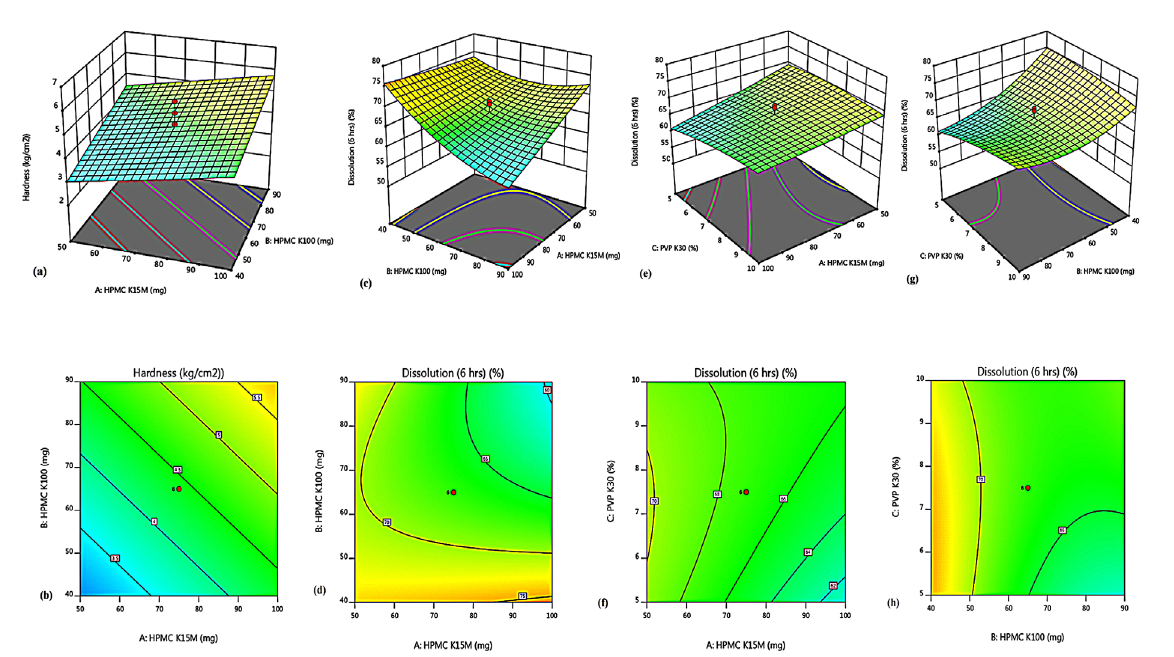
FIGURE 2 - (a) 3D response surface plot for “response-1” (b) 2D contour plot for “response-1” (c) 3D response surface plot for “response-2” obtained by “A” Vs “B” (d) 2D contour plot for “response-2” obtained by “A” Vs “B” (e) 3D response surface plot for “response-2” obtained by “A” Vs “C” (f) 2D contour plot for “response-2” obtained by “A” Vs “C” (g) 3D response surface plot for “response-2” obtained by “B” Vs “C” (h) 2D contour plot for “response-2” obtained by “B” Vs “C”.